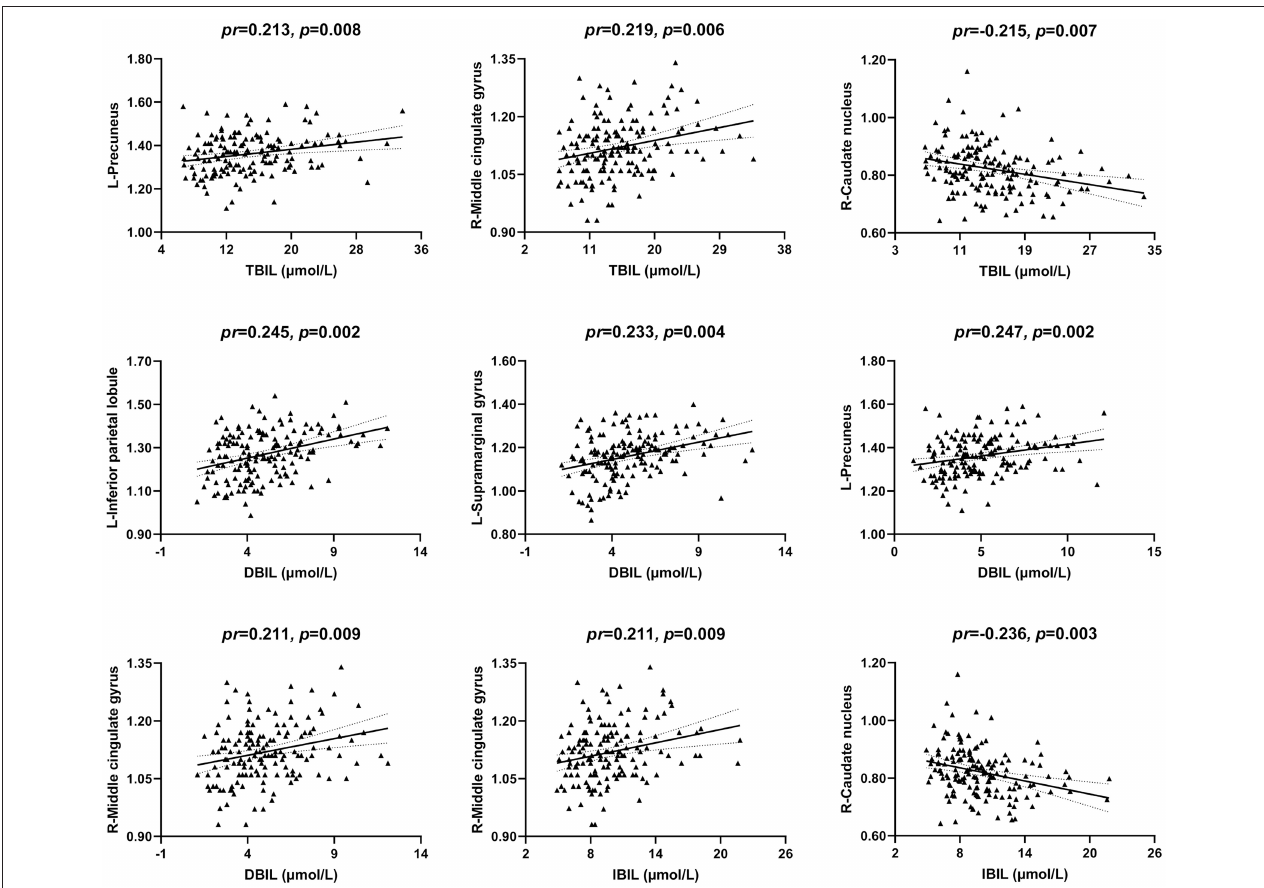
FIGURE 4 | Scatter plots of the correlations between serum bilirubin and ReHo. Abbreviations: ReHo, regional homogeneity; TBIL, total bilirubin; DBIL, direct bilirubin; IBIL, indirect bilirubin; pr , partial correlation coefficient; L, left; R, right.